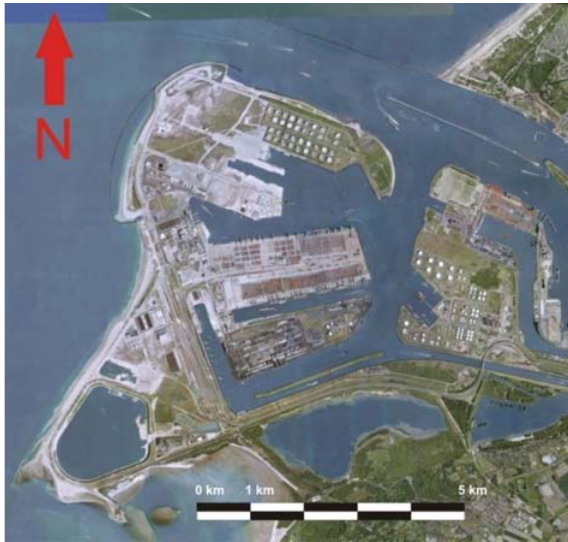
Fig. 2. Th e Port of Rotterdam (Th e Netherlands)